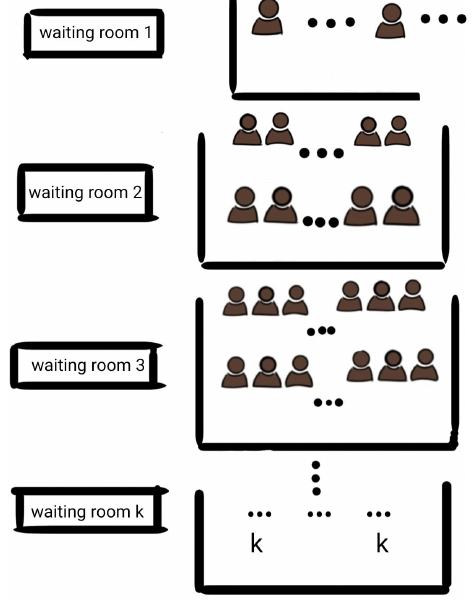
Figure 1. Waiting room for type j where j = 1,2,...,k.